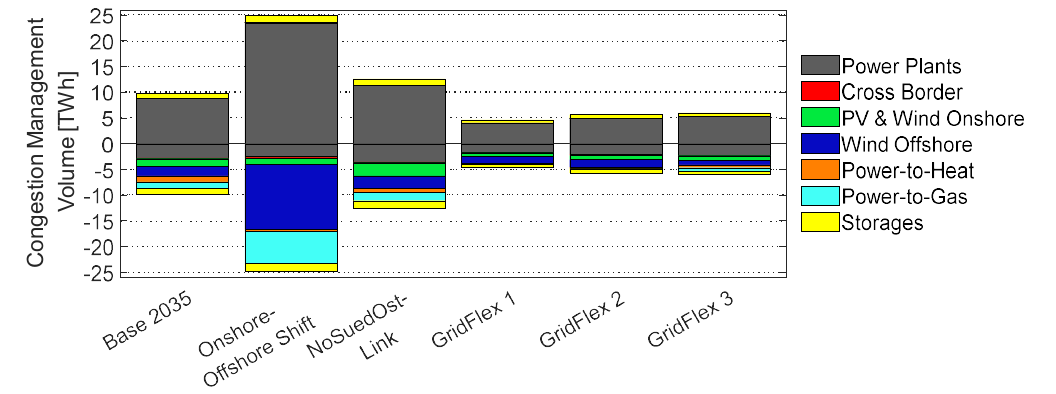
Figure 11. Preventive congestion management interventions for scenario 2035 and corresponding sensitivities.